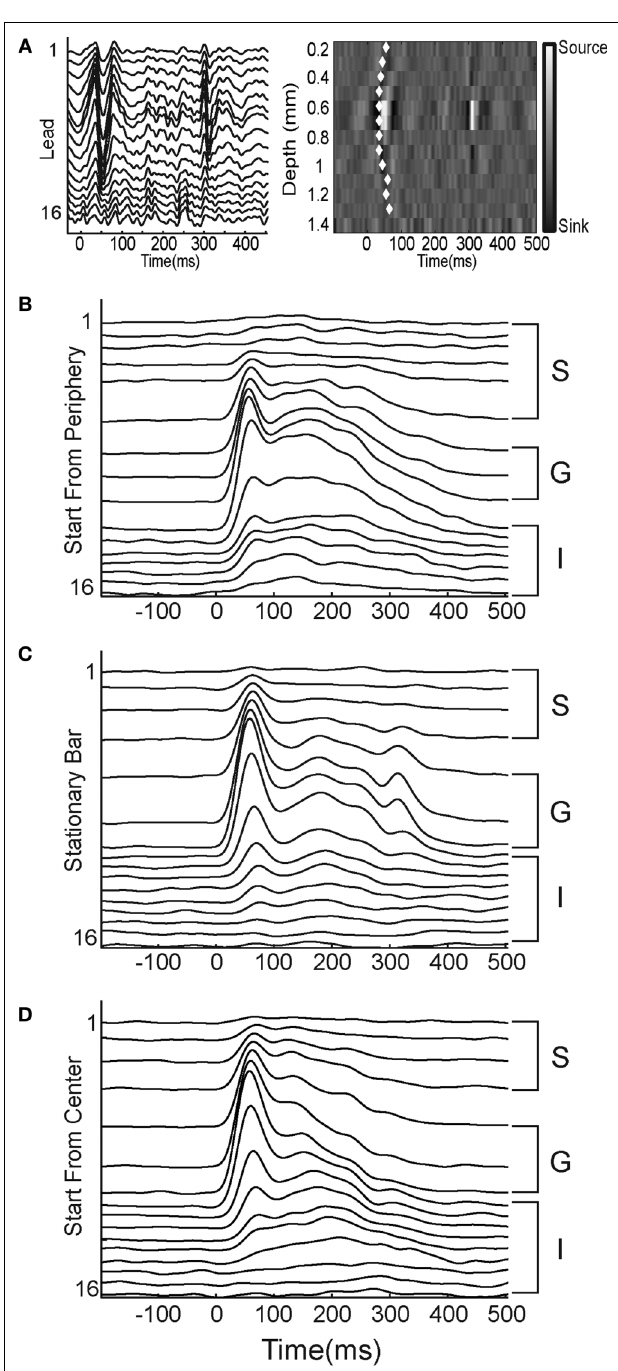
FIGURE 2 | Laminar MUA at the retinotopic sites of the appearance of the bar. (A) Laminar local fi eld potentials (left) and CSD (right) in response to a stationary bar presented for 250 ms at the CFOV. Note the sinks in layer IV 30–35 ms after the start of the stimulus and again at 290 ms (OFF response). The white diamonds mark the onset of statistically signifi cant MUA on each lead ( p < 0.01, see Materials and Methods). (B–D) Laminar PSTHs, average of 50 trials, fi ltered with a 10 ms Gaussian temporal fi lter. S supragranular layers, G granular layer; I infragranular layers of the moving bar starting from the peripheral FOV (B) , the stationary bar (C) , and the moving bar starting from the CFOV (D) . Note similarities in the ON